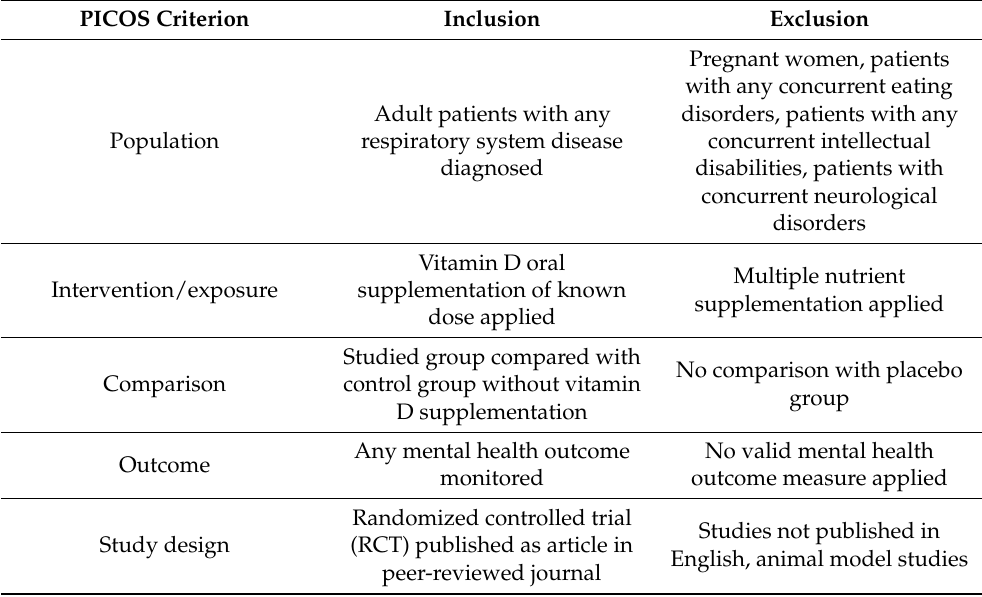
Table 1. The population, intervention/exposure, comparator, outcome, and study design (PICOS)